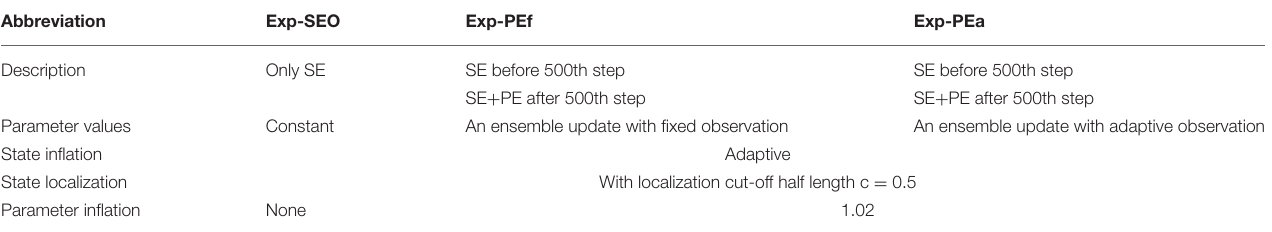
TABLE 2 | Settings of three